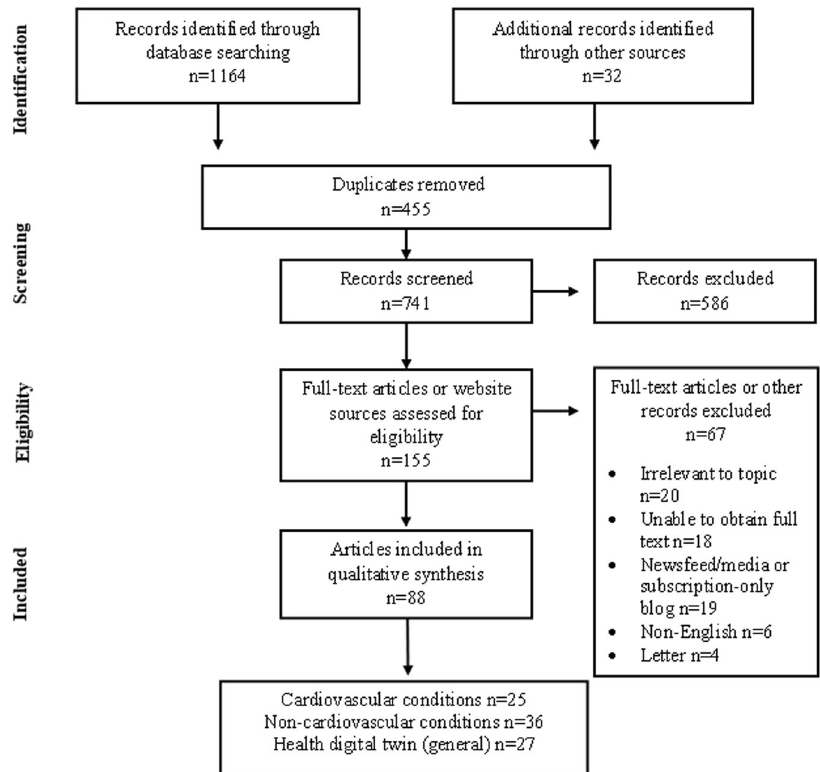
Fig. 1 Flowchart of the search